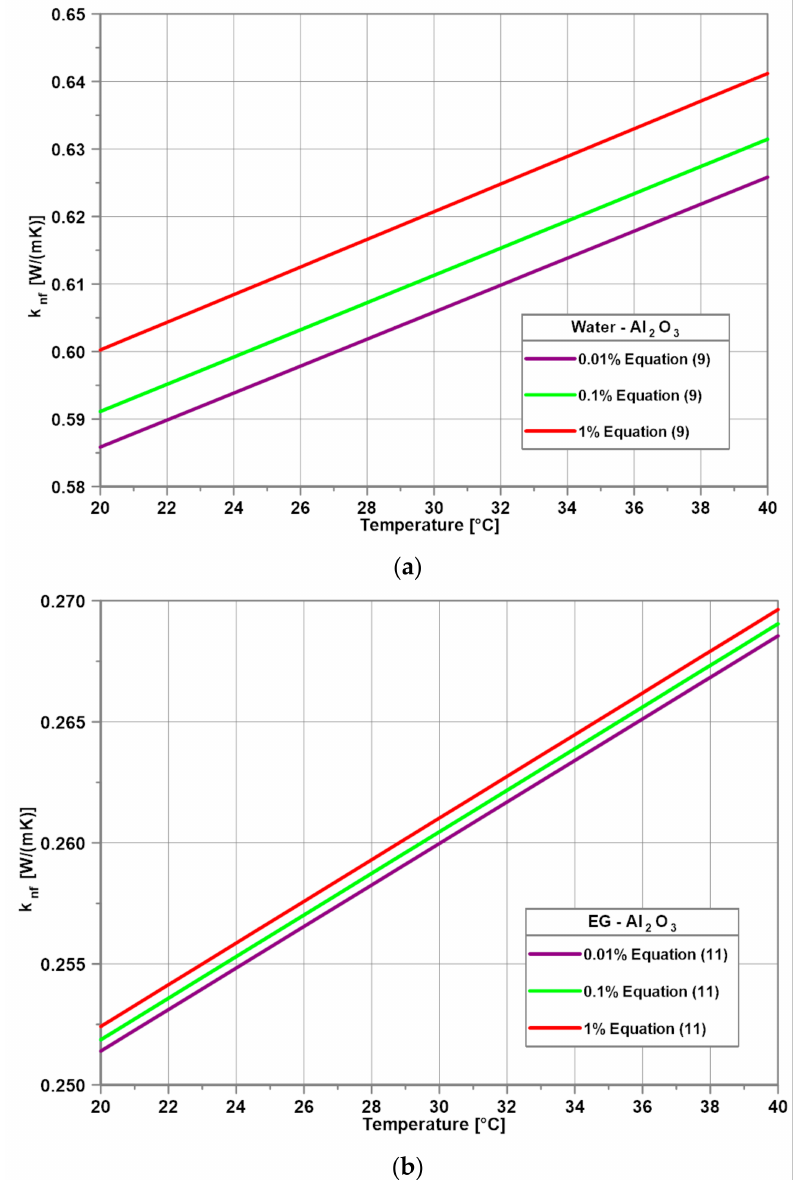
Figure 2. Thermal conductivity of the water-based ( a ) and EG-based ( b )